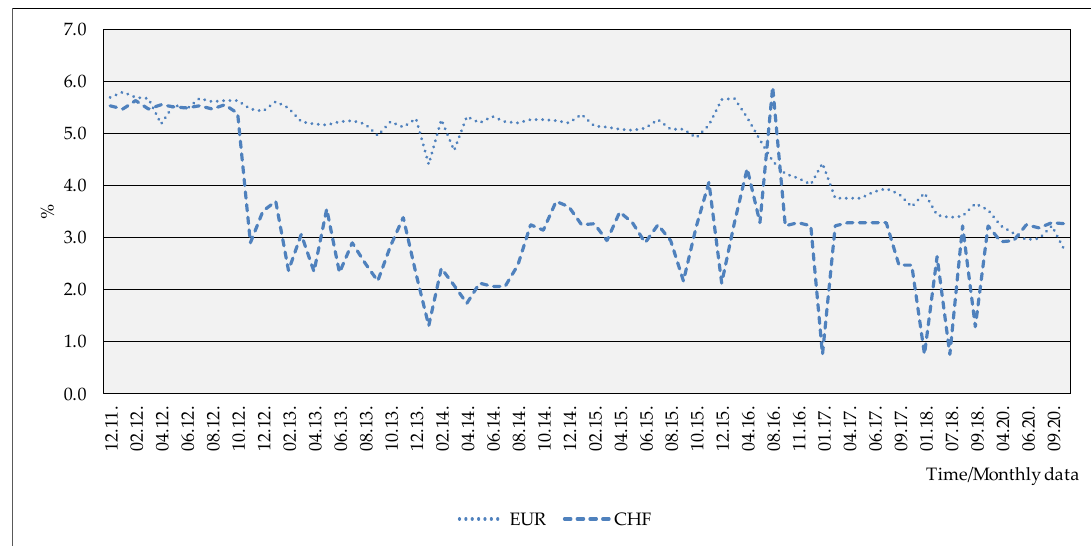
Figure 6. Long-term interest rates on mortgage loans in the Croatian banking sector, monthly data for the December 2011– October 2020 period. Source: Author’s presentation of the CNB data, official website, based on excel table e-g2b-Credit institu- tions' interest rates on kuna loans to households indexed to foreign currency (new business). Table 8. Descriptive statistics of FX mid-rates, daily data for the 11 February 2003–31 December 2008 period.